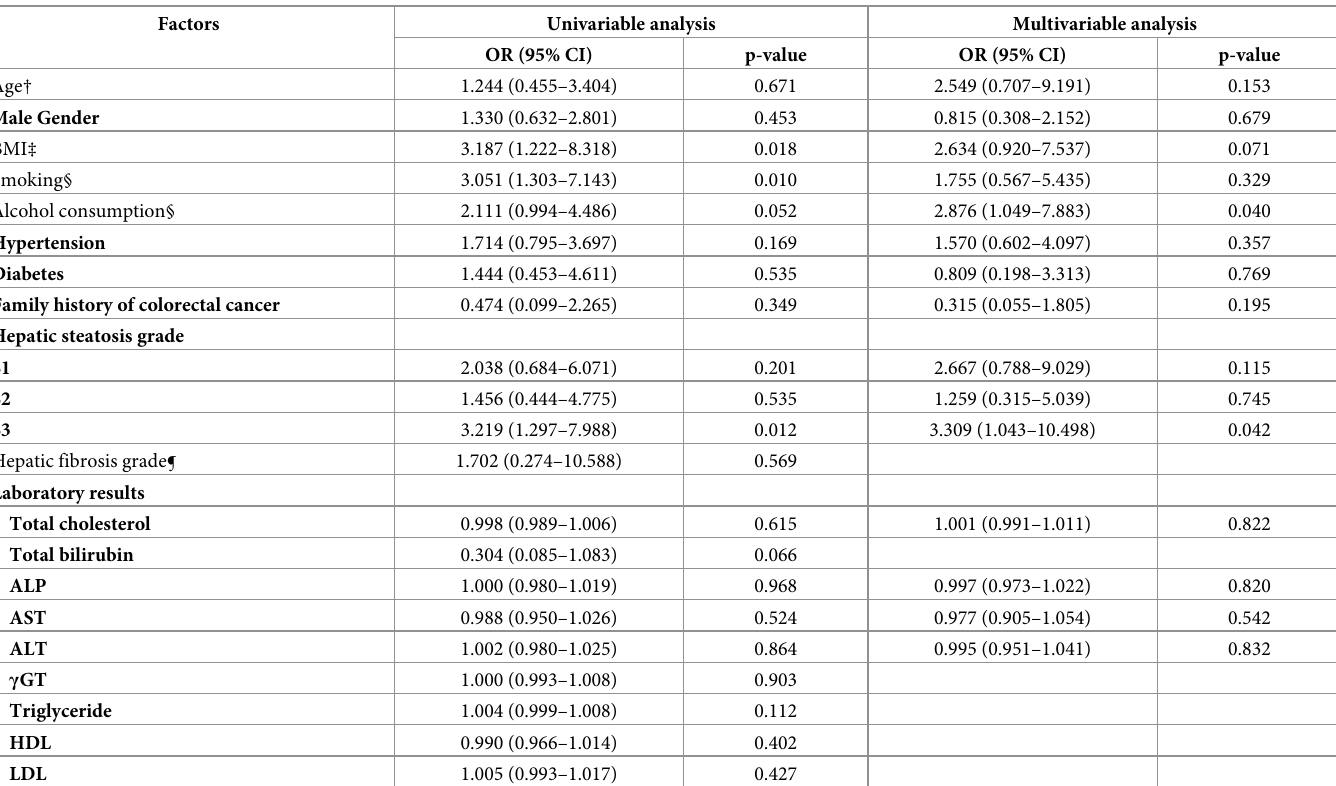
Table 4. Risk Factors for the presence of high risk colorectal